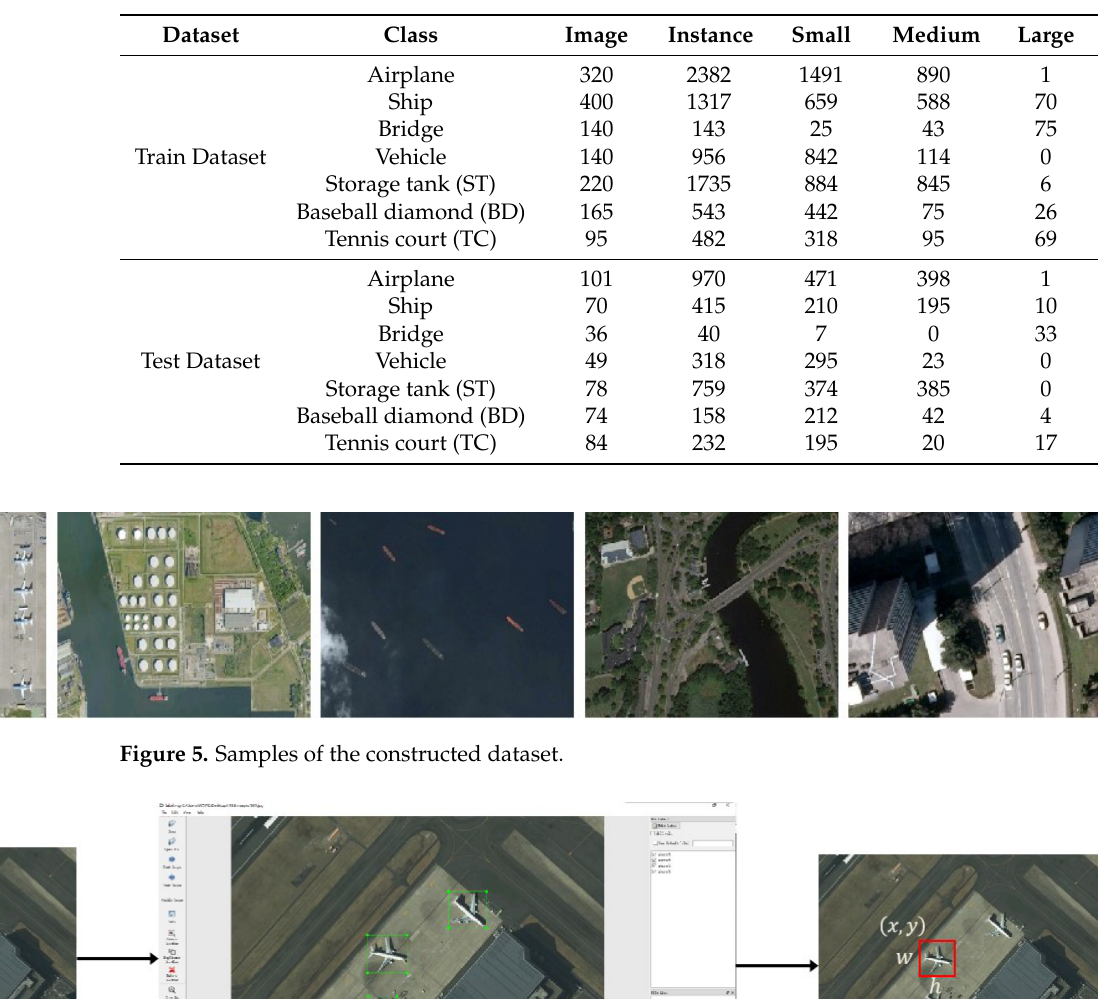
Table 1. The sample statistics of constructed dataset.